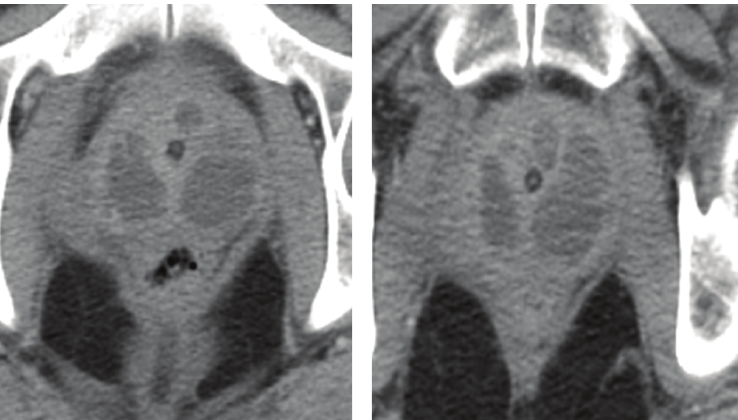
Figure 1: Showing the multiple prostatic abscesses on abdominopelvical